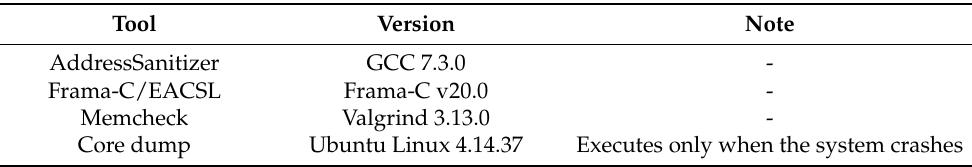
Table 5. Memory corruption detection tools for